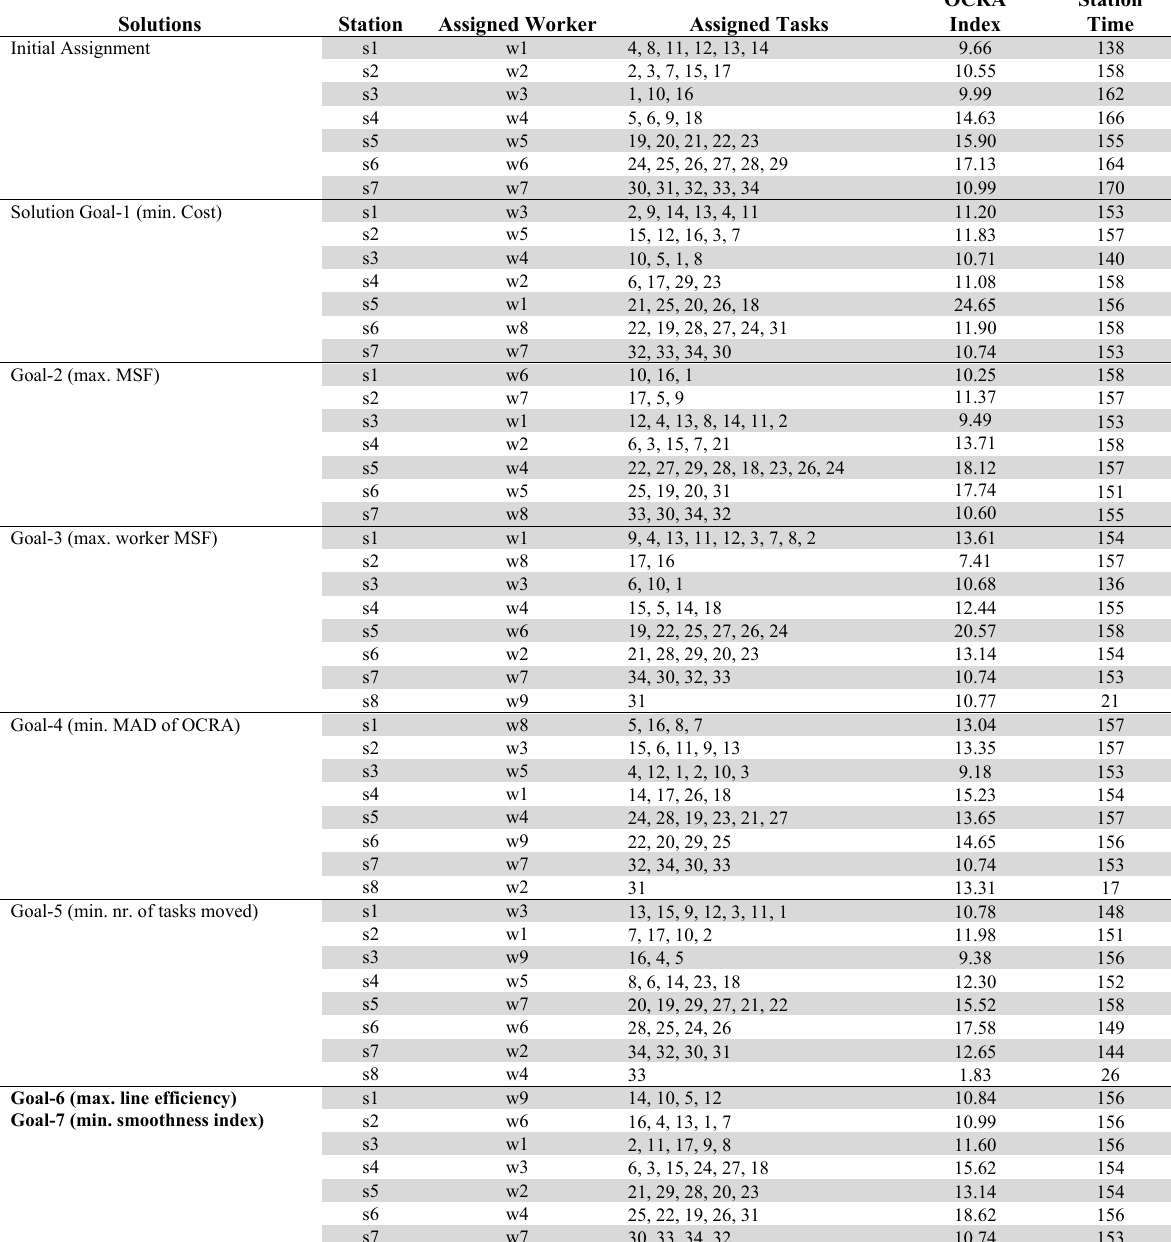
OCRA Station Index Time